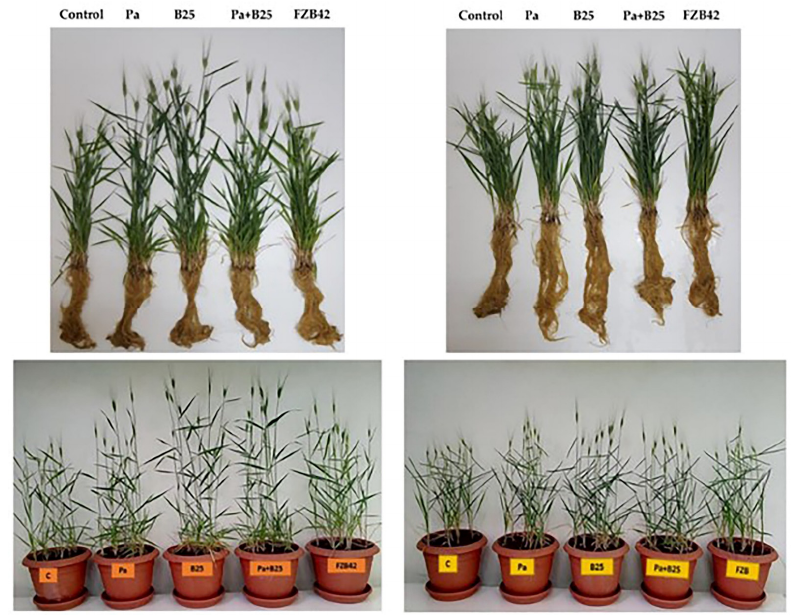
Figure 9. Effect of bacterial inoculation on in vitro wheat plants grown on non-sterile soil. ( Left ) Bousselam variety. ( Right ) Boutaleb variety.